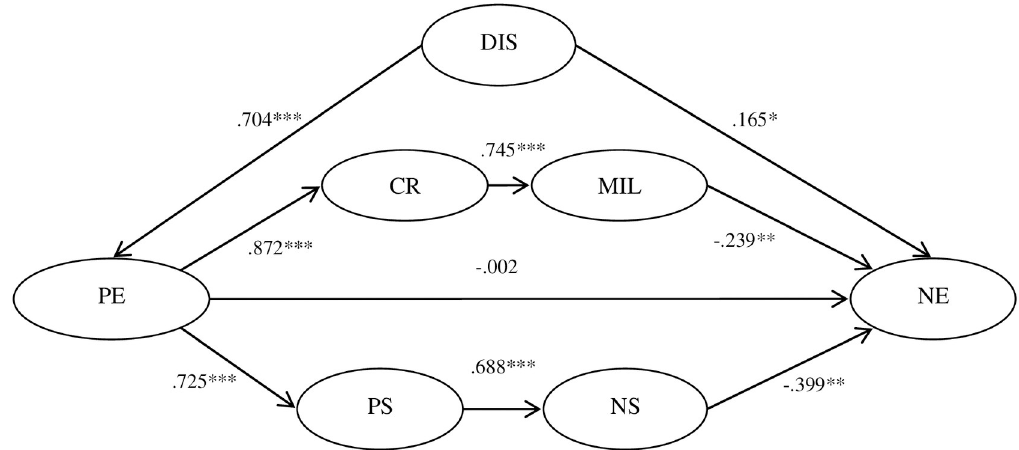
Fig 2. Multiple mediators model between distraction and negative emotions. � < 0.05, �� p < 0.01, ��� p < 0.001, DIS = distraction; PE = positive emotions; CR = cognitive reappraisal; MIL = meaning in life; PS = problem-solving; NS = needs satisfaction; NE = negative emotions.